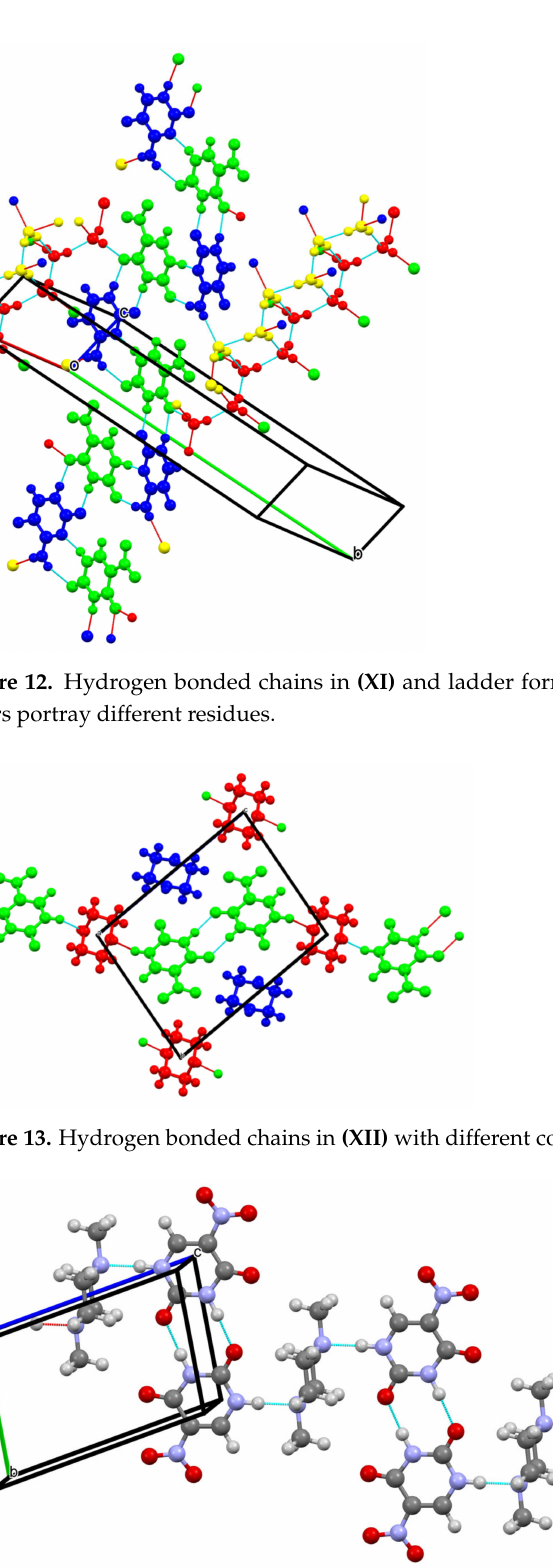
Figure 14. Detail of the 5NU H-bonded chain in (XIII) , showing dimers with the M1 motif. In the co-crystal of 5-nitrouracil and diazabicyclo [2.2.2]octane (DIABCO), there are two symmetry independent 5NU, two symmetry independent DIABCO and four symmetry independent water molecules, all strongly linked via H-bonds. The two independent 5NU are joined in dimers with an almost centrosymmetric M2 motif. The water molecules